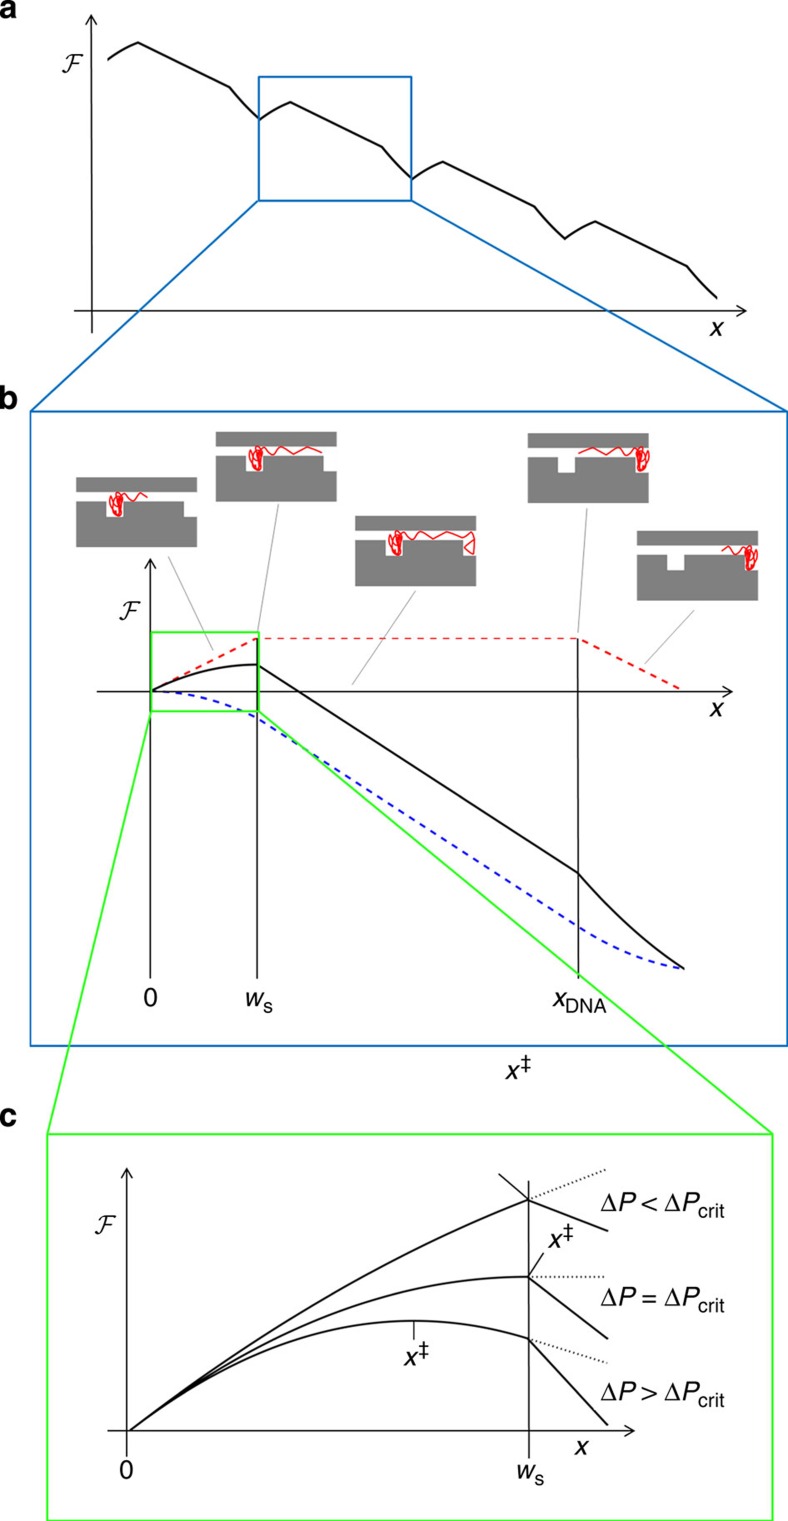
Energy landscape experienced by a DNA molecule in the nanogroove
array.(a) Free energy  experienced by the
molecule when driven by the force field from the buffer flow through a
series of entropic traps. (b) Free energy  experienced by a the molecule during a single transition between
adjacent grooves. Insets show schematic drawings of the physical situation
corresponding to five values of x. Here x is the x
coordinate inside the nanoslit of the leading end of the DNA strand until
that end descends into the next nanogroove. From that point and until the
next state of quasi-equilibrium has been reached, further increase in
x describes the length of DNA that has entered the next
nanogroove. Thus, x=0 corresponds to the equilibrium state in
which the whole strand resides in the left nanogroove. At
x=ws the leading end enters the next
nanogroove. At x=xDNA, the trailing end of
the DNA leaves the upstream nanogroove. At
x=xDNA+ws, the
DNA is again in quasi-equilibrium in the next groove, and the energy
landscape repeats itself downstream from there as shown in a. Red
dashed line: contribution to the free energy due to loss of entropy; blue
dashed line: loss of potential energy of the DNA due to higher hydrodynamic
drag on the part of the strand inside the nanoslit; black full line: total
free-energy difference . (c) Zoom on
the energy landscape for 0<x≤ws. The
transition state at x‡≤ws
is the point with maximal free energy. For
ΔP≤ΔPcrit,
x‡=ws; for
ΔP>ΔPcrit,
x‡<ws. (Note that we
have assumed that xDNA⩾ws, which is
always true in the present study. For DNA too short to span the width of the
slit, xDNA<ws, and TST predicts
x‡≤xDNA.)